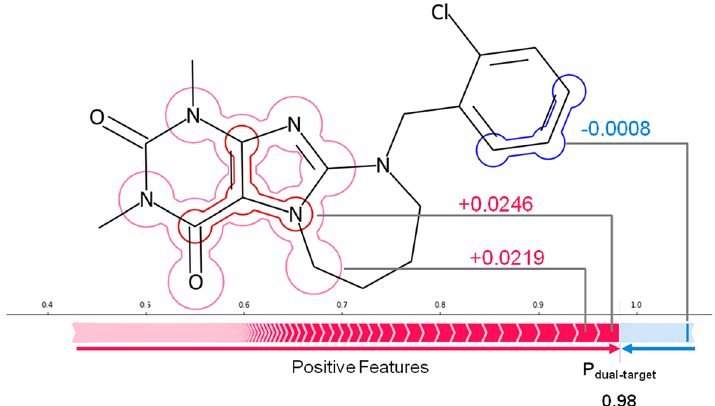
Figure 1. Shapley value analysis. For a test compound, positive (red) and negative (blue) SV feature contributions yield a probability P of DT activity. In this case, contributions from all but one feature present in the compound are positive. The sum of the base value of the classifier (0.5) and all feature importance values results in a probability of DT activity of 0.98.